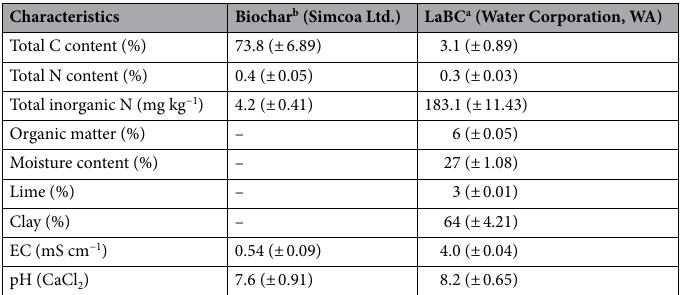
Table 1. Basic chemical properties of soil amendments (LaBC and biochar). Values represent the means (and standard errors) of three replicates (n = 3). a Data adapted from Shanmugam et al. 20 . b Data adapted from Mickan et al. 49